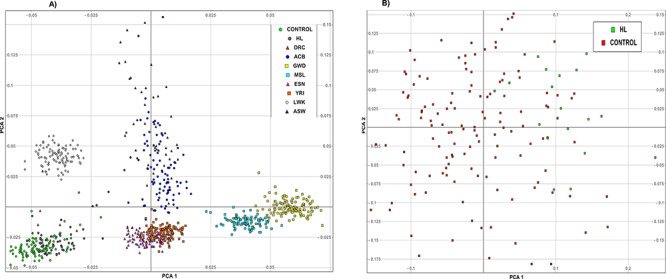
PCA plot for nine African populations. (A) The confirmation of the origin of the control and patient groups from the same ethnolinguistic background, which cluster in the lower left corner of the plot and are represented by the green and gray circles for the controls and patients groups, respectively. The inherent diversity of the individuals within the patients and controls groups is represented in (B), where the red squares indicate the controls group and the green squares represent the HI patients group. DRC: Demographic Republic of Congo (red triangle); ABC: African Caribbean in Barbados (blue circle); GWD: Gambian in Western Division –Mandinka (yellow scare); MLS: Mende in Sierra Leone (light blue square); ESN: Esan in Nigeria (purple triangle); YRI: Yoruba in Ibadan, Nigeria (orange square); LWK: Luhya in Webuye, Kenya (grey diamond); ASW: African Ancestry in Southwest United States (blue triangle).